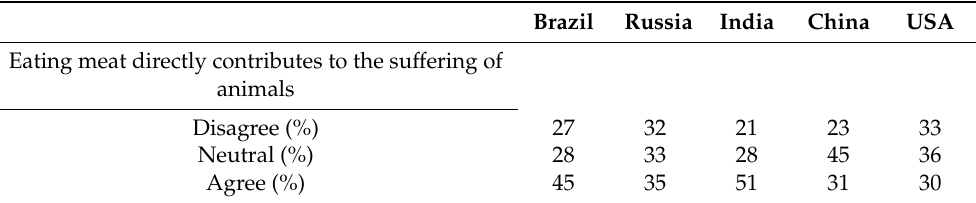
Table 3. Percentage of respondents to the question in each of the countries in each of the categories disagree, neutral, and agree.